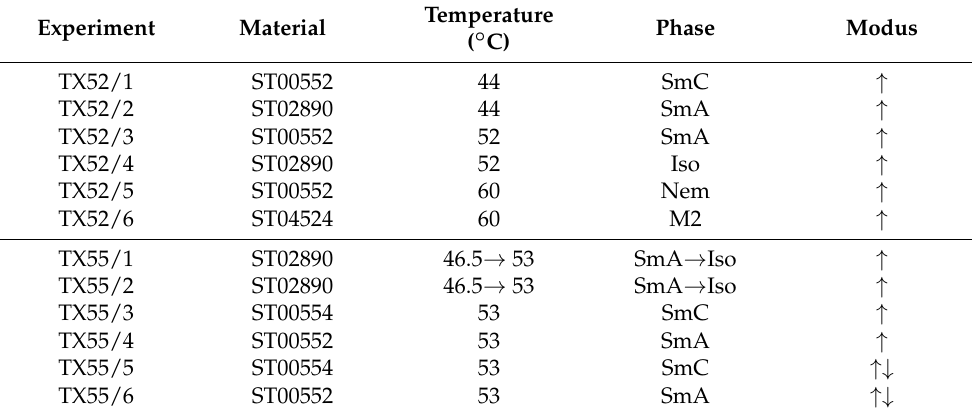
Table 1. Materials, temperatures and drawing protocols: TX52/ n ( n = 1...6) represent the experiments that were performed onboard TEXUS 52, and TX55/ n represent those per- formed onboard TEXUS 55. The label ↑ indicates that the columns were only expanded, whereas ↑↓ marks experiments in which the columns were expanded first and shortened later. Temperatures were kept constant, except during TX55/1,2 in which a phase transition was triggered within the bridges.